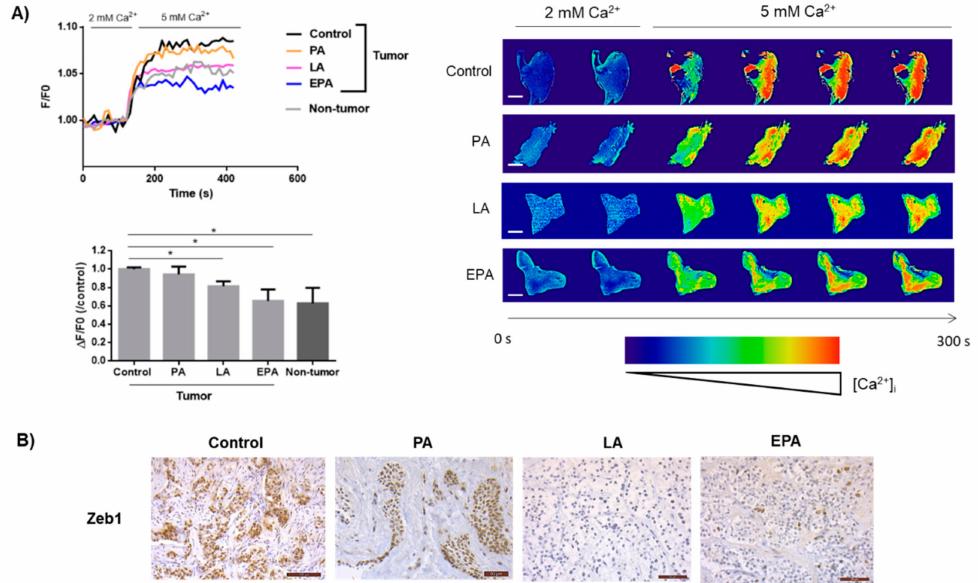
Figure 5. LA and EPA reduces Ca 2 + entry in human PCa slices. ( A ) Human PCa slices ( N = 9) and nontumor prostate slices ( N = 4) were obtained from 11 patients, and were treated or not for 48 h by FA (60 µ M). Slices were incubated with Rhod-2-AM in 2 mM CaCl 2 PSS. After a stabilization period, CaCl 2 was added to the bath to reach a final concentration of 5 mM Ca 2 + . Analyses were performed with ImageJ 1.52a analysis software. The Ca 2 + fluorescence traces were expressed as F / F0 (F0: basal fluorescence signal obtained in 2mM Ca 2 + ). Rate of real-time fluorescence images represented is 0.2 Hz. Scale bars = 2 mm. Diagrams represent the variations of Ca 2 + signal expressed by ∆ F / F0 ( ∆ F: maximal (5 mM Ca 2 + ) − basal fluorescence (2 mM Ca 2 + )). Statistical di ff erences are indicated: * p < 0.05 (Wilcoxon test). Results are expressed as mean ± SEM. ( B ) Organotypic cultures of human PCa slices with initial Zeb1 expression were obtained from 3 patients, and were treated with PA, LA and EPA (60 µ M) for 48 h. When compared to control (almost 100% positive cells), Zeb1 expression remained identical after PA treatment, whereas both LA and EPA treatment led to decrease Zeb1 staining, with, respectively, no and 10% positive